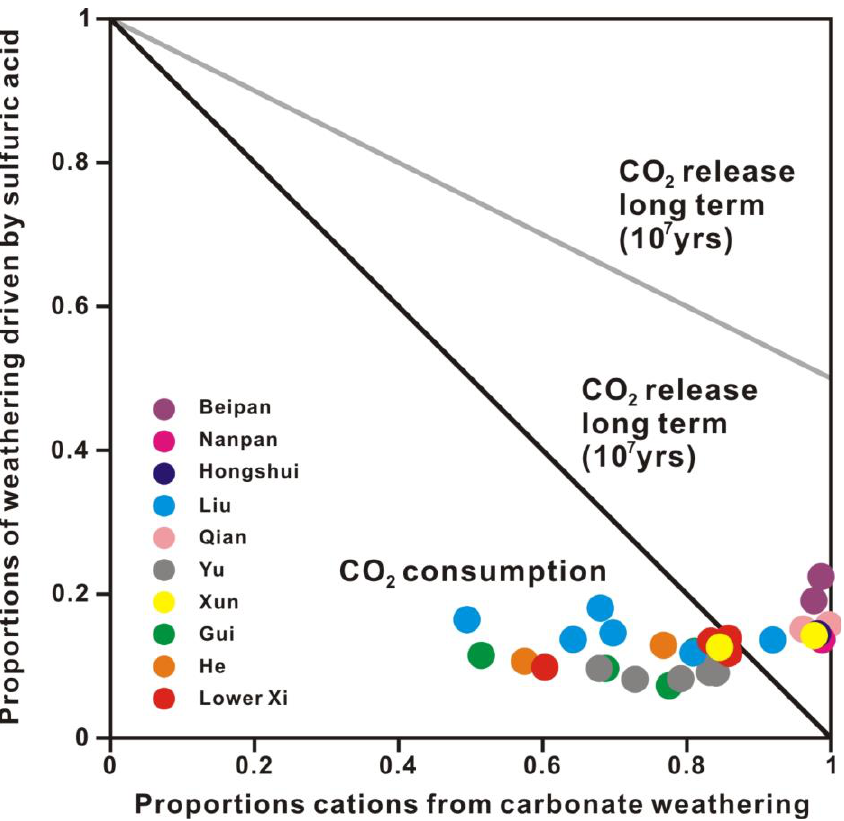
Figure 12. Diagram showing the effect of chemical weathering on atmospheric CO 2 . The long-term and short-term consequences are considered. Proportions of weathering driven by sulfuric acid are calculated by SO 42 − /Σ +weathering , and proportions of cations from carbonate weathering are calculated by Σ +carbonate /Σ +weathering (equivalent ratio). The insert is an expanded view of the Xi River.